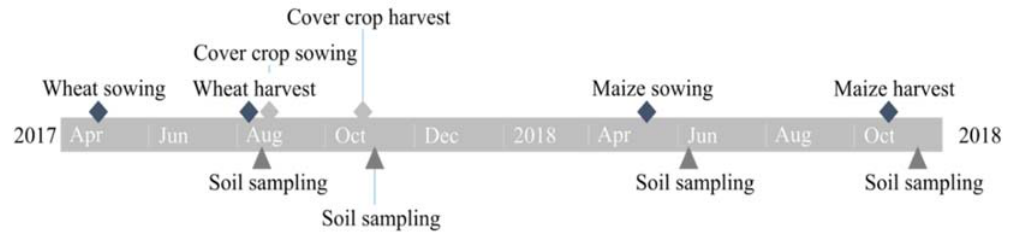
Figure 1. General timeline of sowing and harvesting of various crops and soil sampling throughout the experiment.